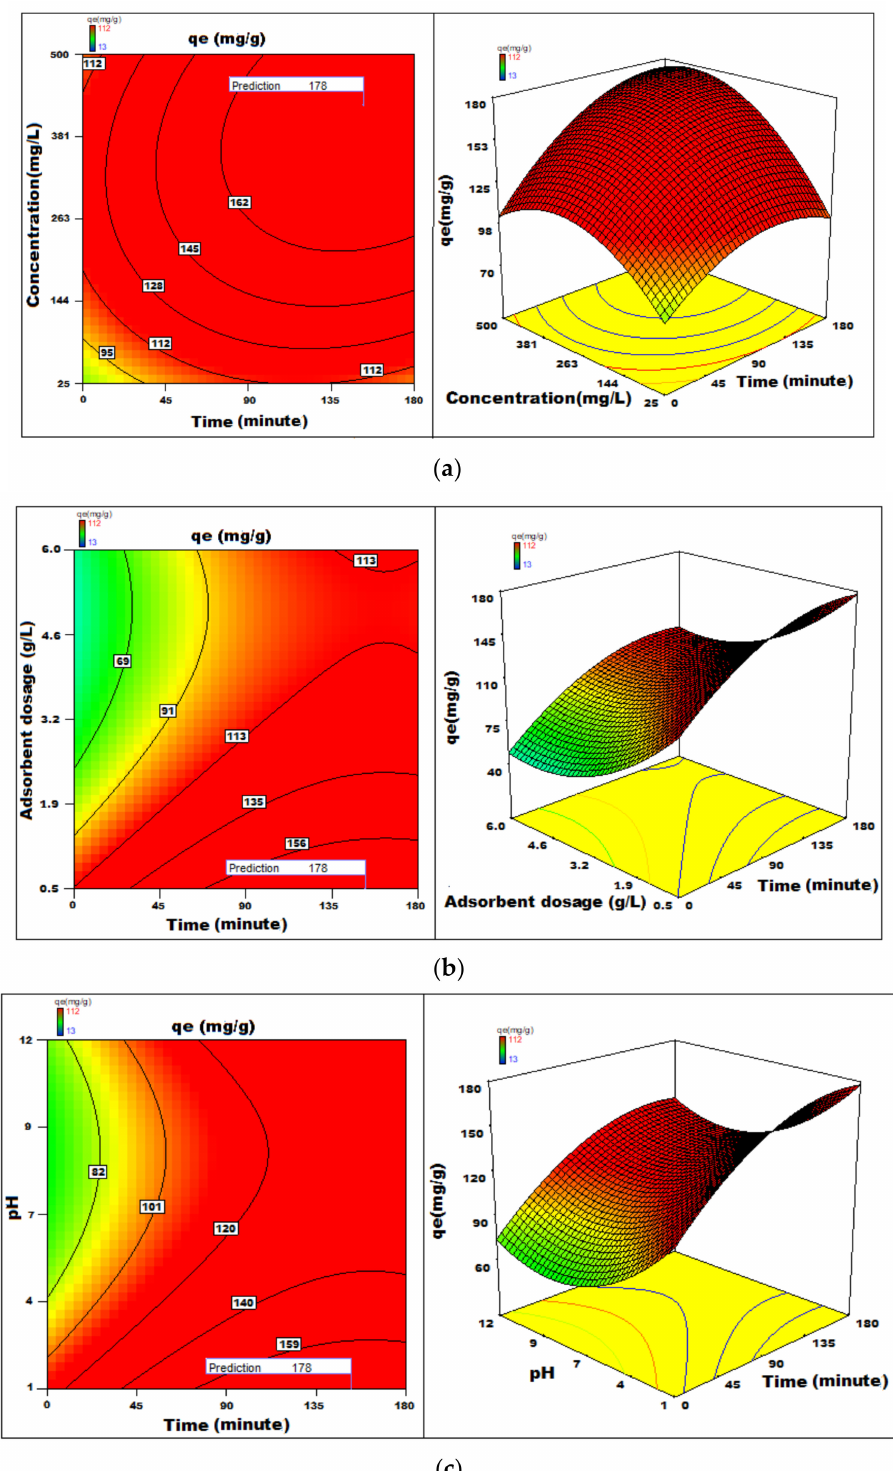
Figure 14. ( a – c ) 3D-surface plots and 2D-contour plots of variation of adsorption capacity with different